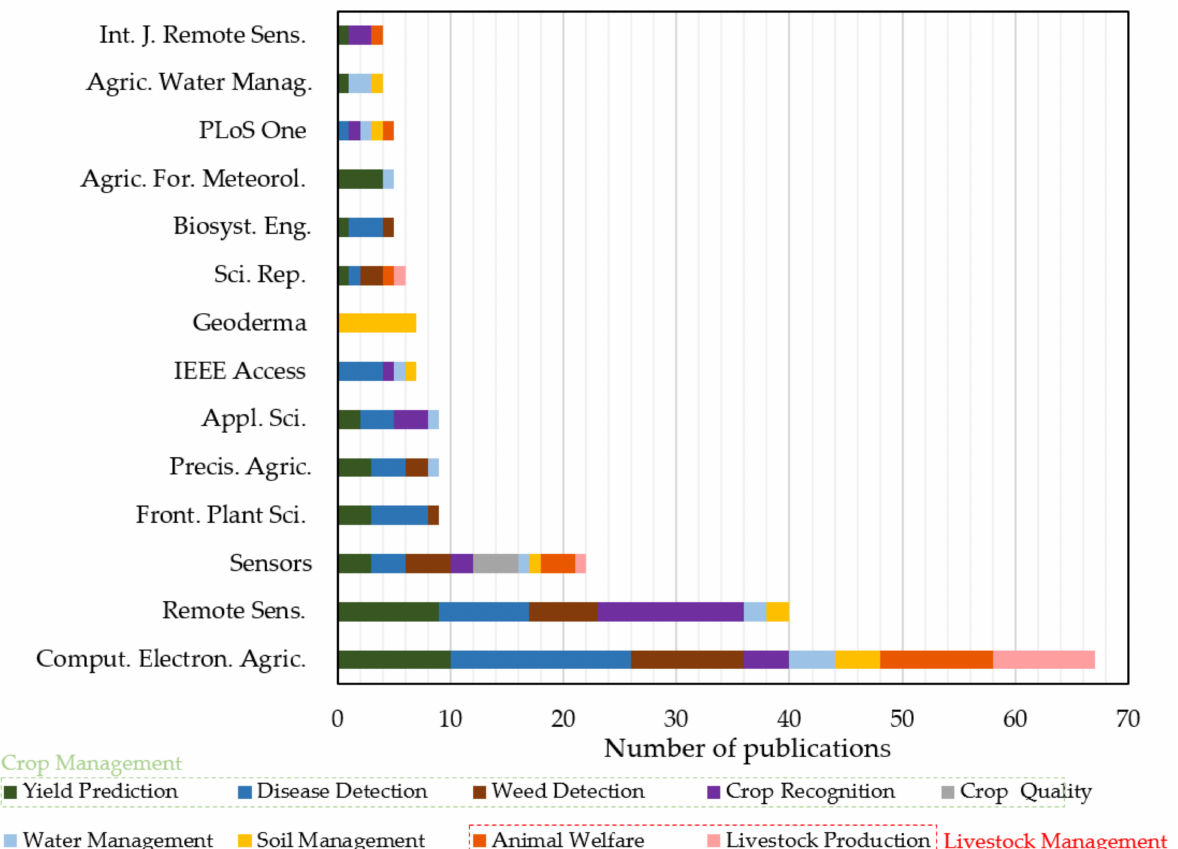
Figure 7. Distribution of the most contributing international journals (published at least four articles) concerning applications of machine learning in